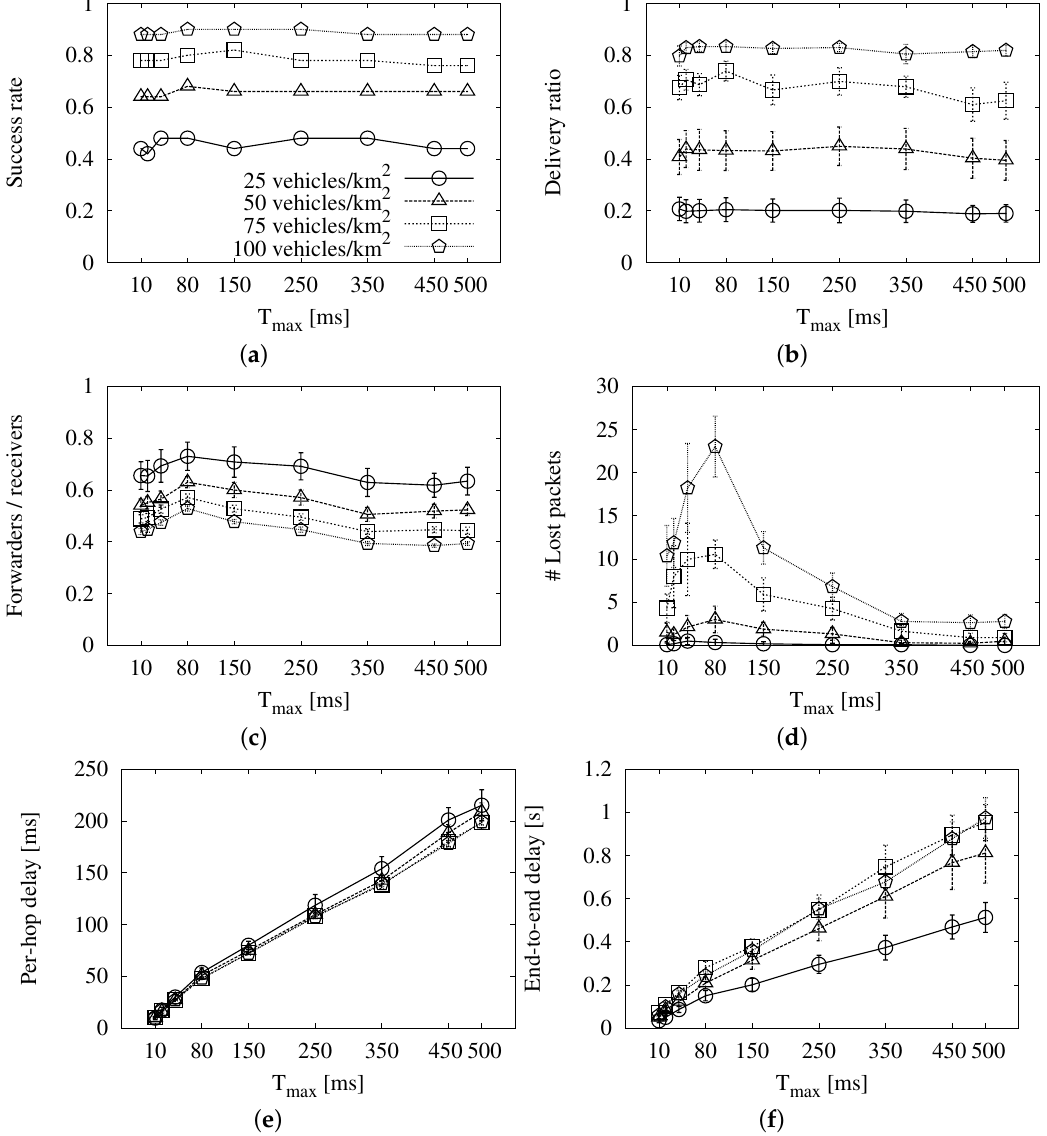
Figure 3. Simulation results of the base roadway scheme with different T max values in the New York scenario: ( a ) long-reach success rate; ( b ) delivery ratio; ( c ) forwarding ratio; ( d ) number of lost packets; ( e ) average per-hop delay; ( f ) average end-to-end